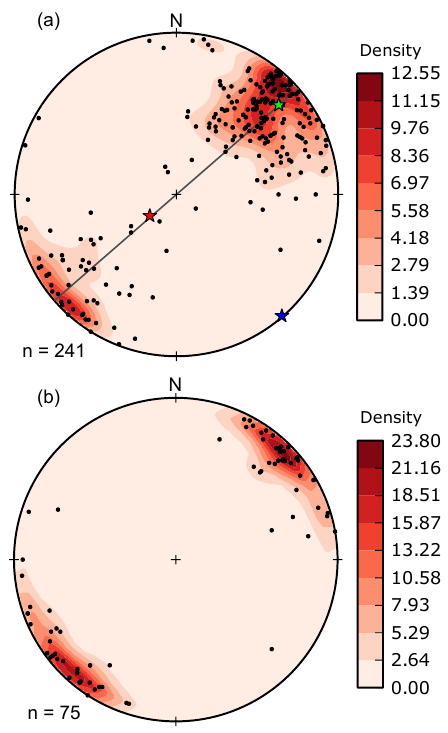
Figure 12. All orientation data at Nkana South, Nkana Central and Mindola. Contouring is done by Fisher distribution. (a) Poles to S 1 foliation have a maximum density at 047/07. (b) Poles to S 2 folia- tion have a maximum eigenvector of the distribution at